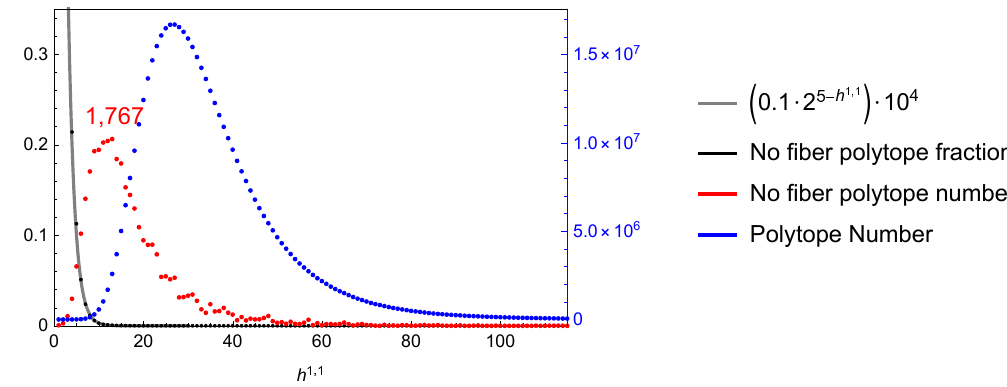
Figure 3 . The distribution of 4D re(cid:13)exive polytopes without a 2D re(cid:13)exive subpolytope (cid:12)ber (red) compared to the total number of 4D re(cid:13)exive polytopes (blue) as a function of Hodge number h 1 ; 1 , and the fraction without (cid:12)bers (gray). Note that the vertical axis is normalized di(cid:11)erently for each of the three curves.